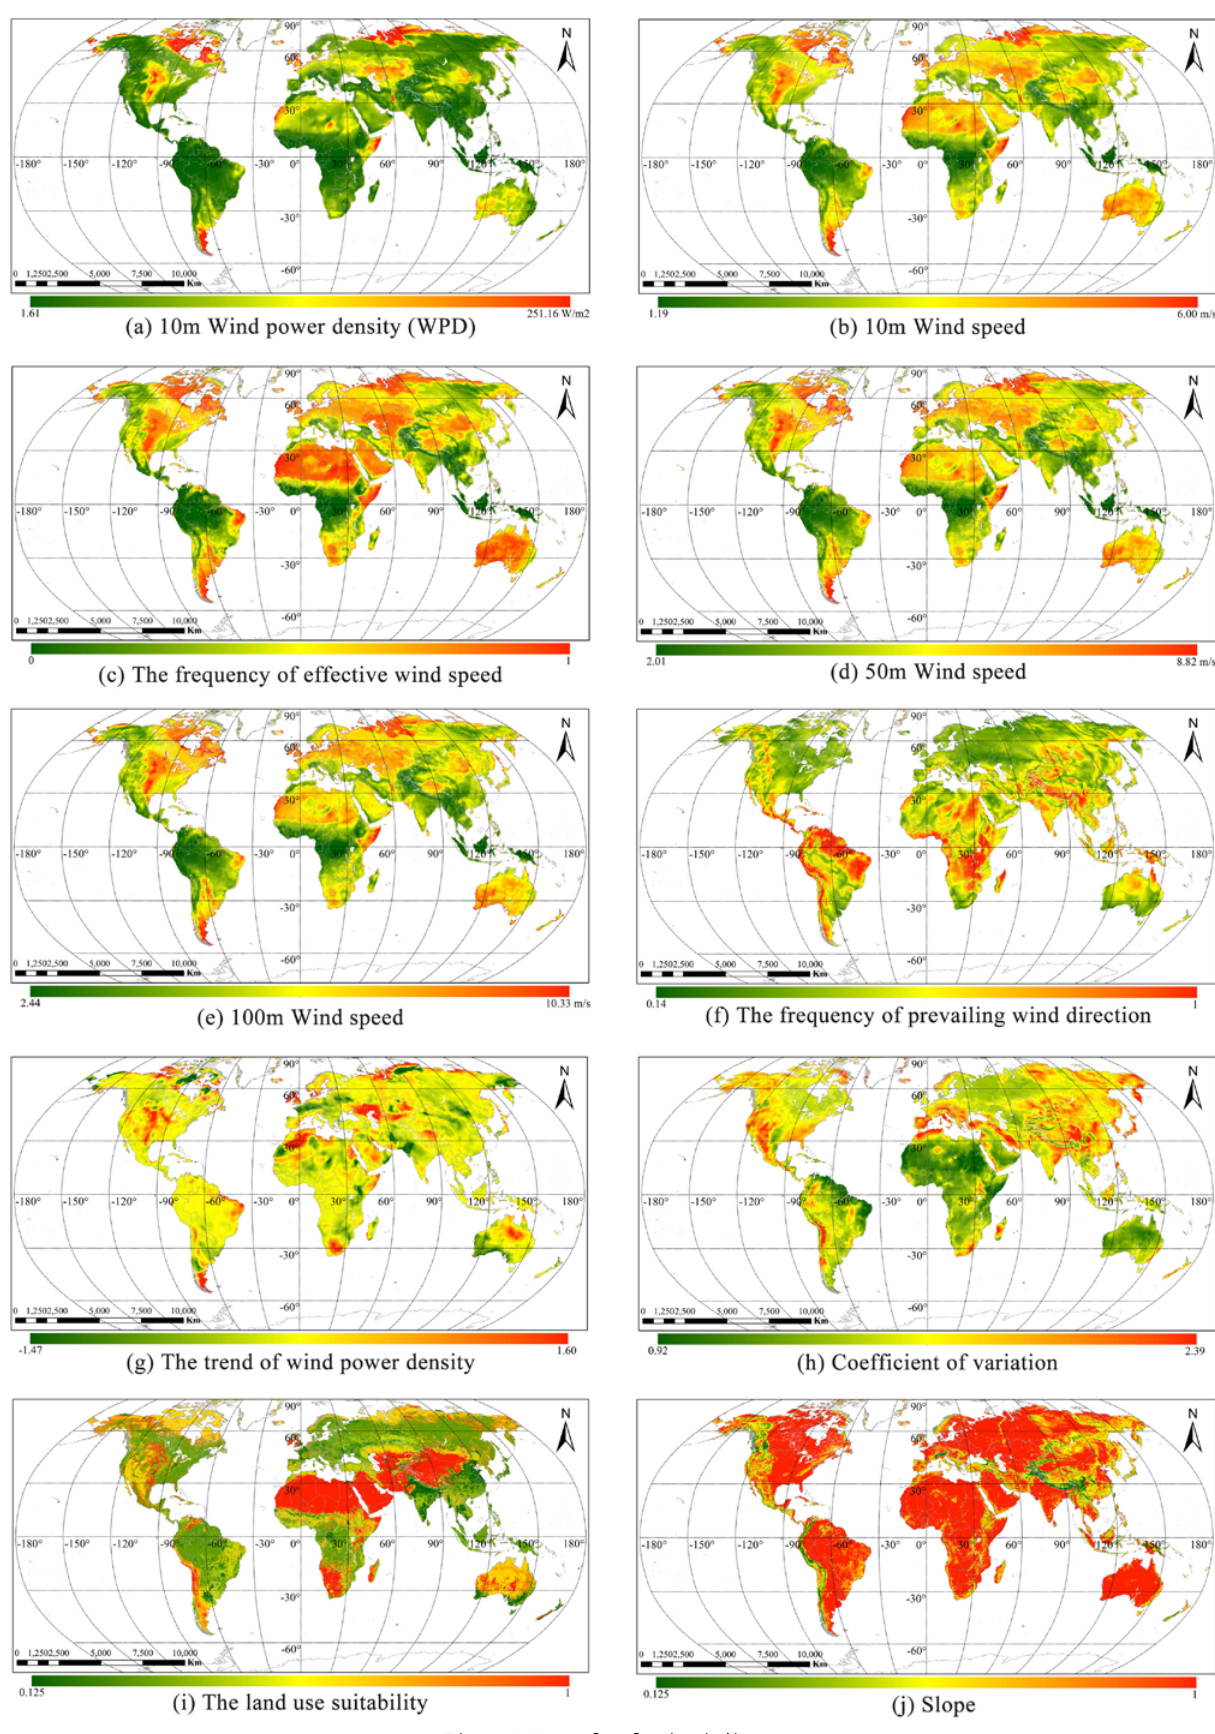
Figure 1. Map of evaluation